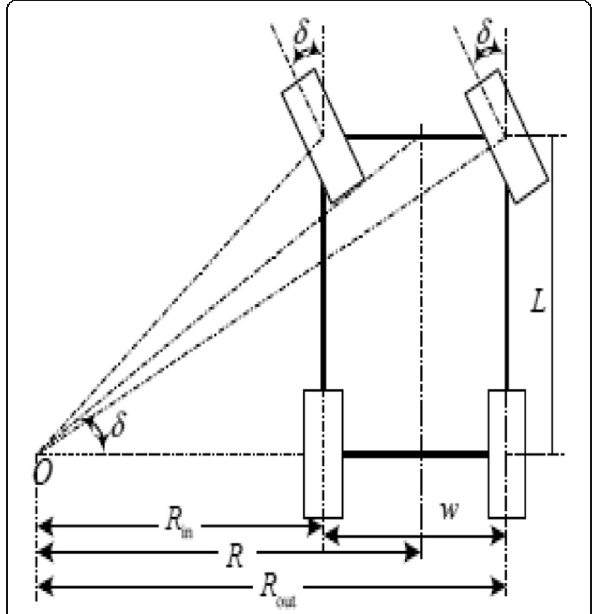
Fig. 5 The Ackermann-Jeantnat